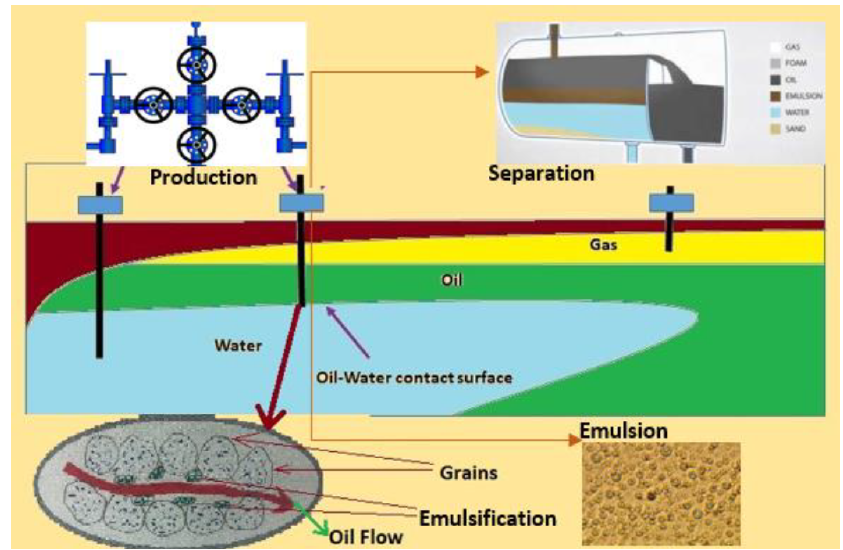
Figure 1. Phenomena of emulsification at production